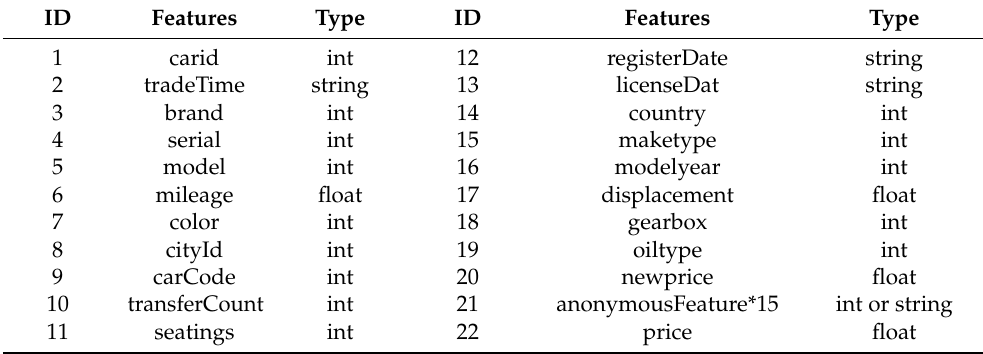
Table 1. Basic characteristics of the data.